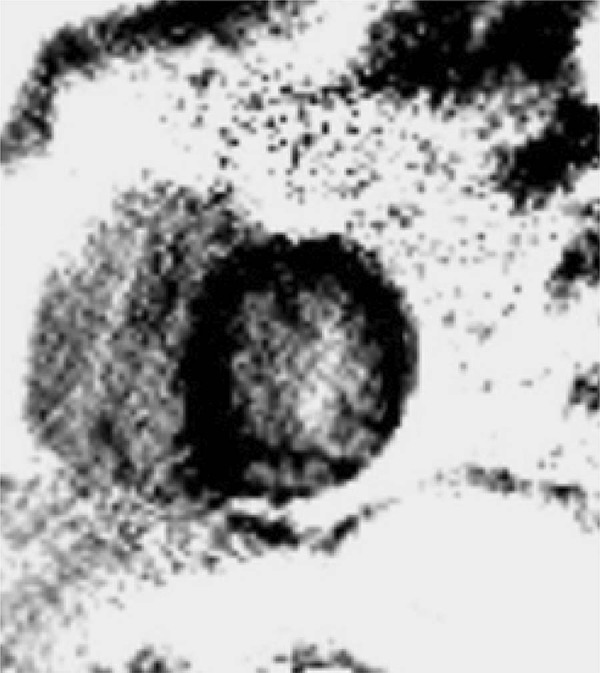
–
Short- axis delayed contrast-enhanced PSIR cardiac MR image, showing focal subendocardial transmural and subepicardial enhancement areas, mostly in the inferior and inferolateral left ventricular walls.